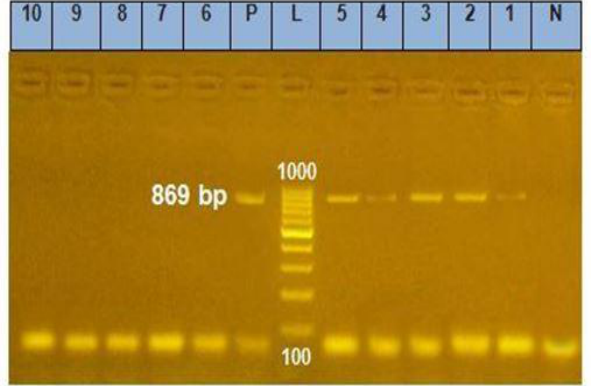
Fig.3: Ethidium bromide stained 1.5% agarose gel revealed bands of PCR products at the expected size (869pb); Lanes 1- 5 showed positive samples submitted for sequencing. Lane P for positive control, Lane N for the negative control, Lane L 100 bp ladder.